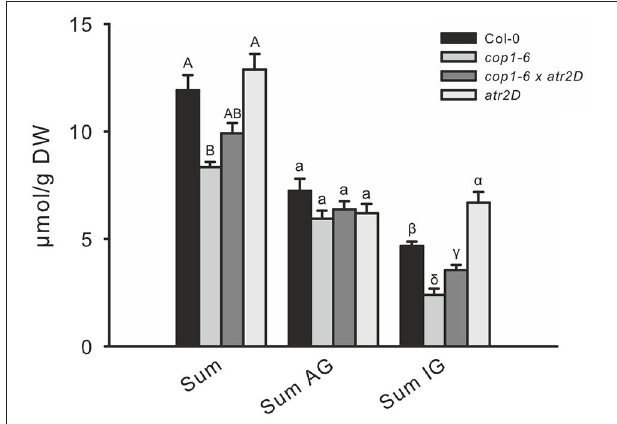
FIGURE 7 | The release of MYC3/ATR2 from inactive complexes partially complements low indole GSL phenotype of cop1 . To release MYC3 from inactive complexes in cop1–6 , the atr2D gain-of-function line was combined with cop1–6 to compare the GSL levels with that in cop1–6 . Data are means ± SE from four independent experiments with five or six biological replicates in each ( n = 22). Values marked with different letters differ significantly from each other (the Kruskal-Wallis test followed by a Mann–Whitney pairwise test with Bonferroni-corrected p -values, p <